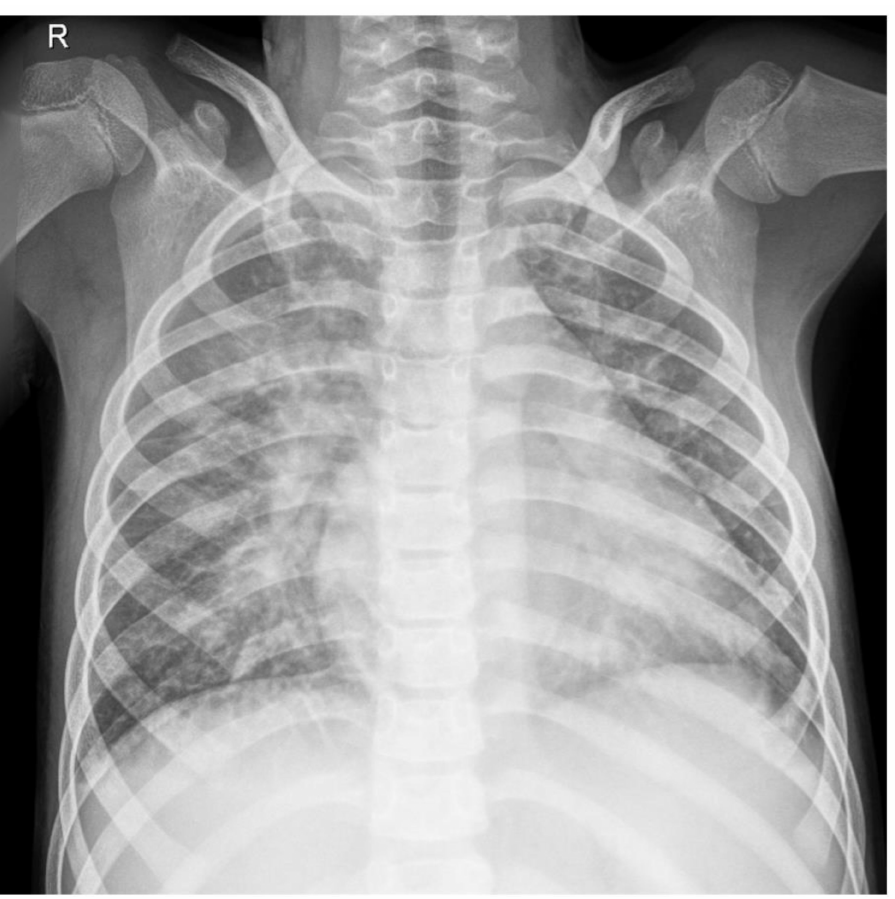
Figure 2. Chest X-ray showing veiling of both costo-diaphragmatic recesses and numerous reticulon- odular opacities, with erased contour and tendency to confluence, diffusely distributed in both lung fields. R,